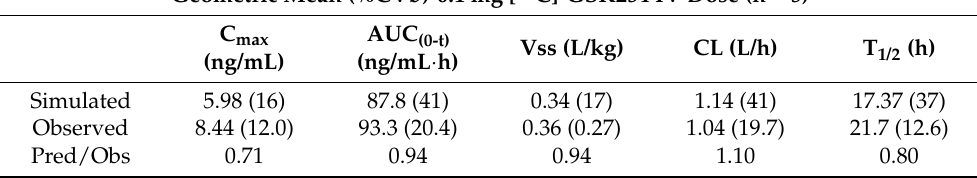
Table 5. Observed vs. predicted pk parameters of IV microdosing of GSK254 in healthy volunteers (ADME study [12]).